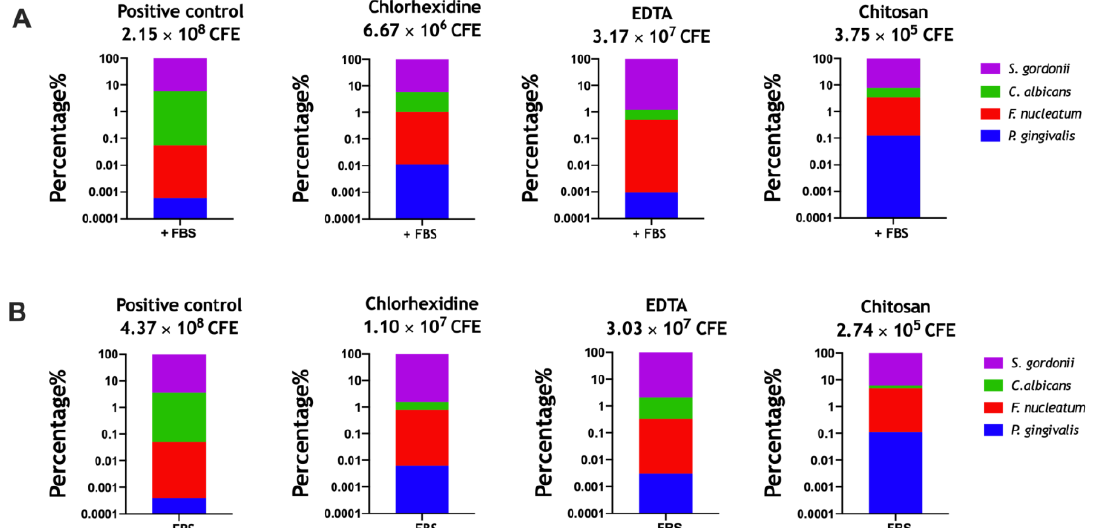
Figure 5. Compositional analyses of re-grown multi-species biofilms in the presence ( A ) and absence ( B )ofFCS.Biofilmsinthe“prevention”groupasdescribedinFigure4wereprocessedforDNAextraction prior to composition analyses via quantitative polymerase chain reaction (qPCR). In brief, biofilms were disrupted, diluted 1:5, then transferred to fresh 6-well culture plates containing chlorhexidine (0.2%), chitosan (0.7 mg / mL), and EDTA (230 mM). Plates were cultured for 24 h to permit biofilm re-growth before DNA was extracted using the DNeasy Extraction Kit, following the manufacturer’s instructions. Average % composition is shown in the bar graphs, data representative of biofilms from three independent repeats (three technical replicates in each experiment). Table 3. Percentage composition of the mixed-species biofilm model following “prevention” treatment.